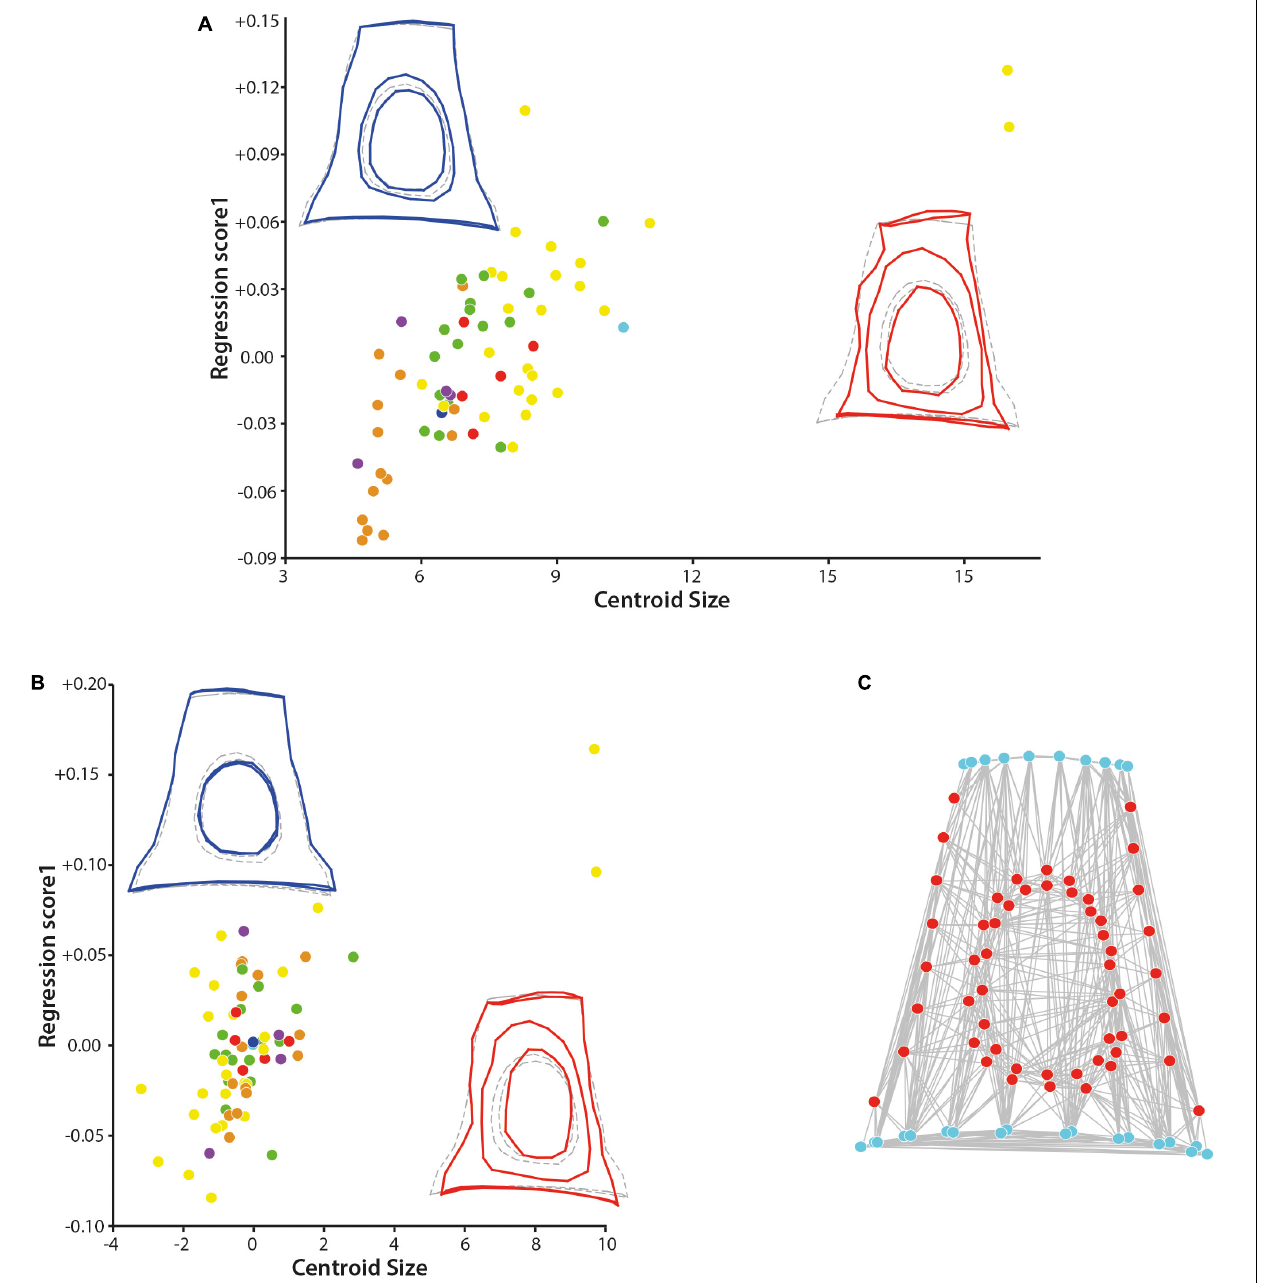
FIGURE 3 | Results of the regression on the centroid size and of the modularity test. (A) Regression of the shape of the stapes on the centroid size and (B) regression of the shape of the stapes on the centroid size pooled within families. (C) Result of the modularity test (similar to the original hypothesis) on the original 3D landmarks dataset, the stapes with size correction dataset, and the stapes with size correction pooled within families (all three analyses give similar result, graph shows the first result, the two others are not shown). Stem Pecora violet; Antilocapridae red; Bovidae, yellow; Cervidae, green; Tragulidae, orange; Giraffidae, and light blue; Moschidae, dark blue. Statistical results are available in Supplementary Data S3 .